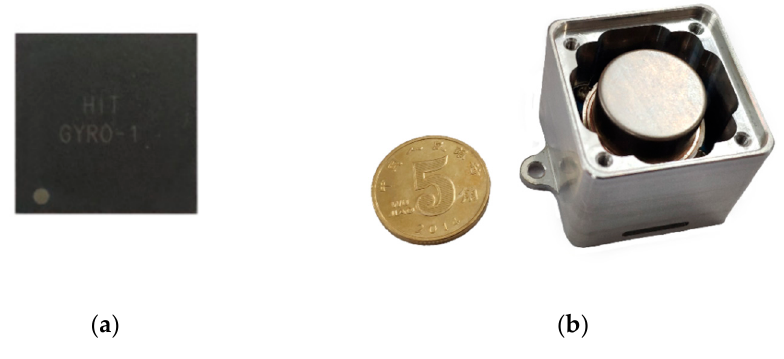
Figure 10. Simplified schematic of the analog modulator.